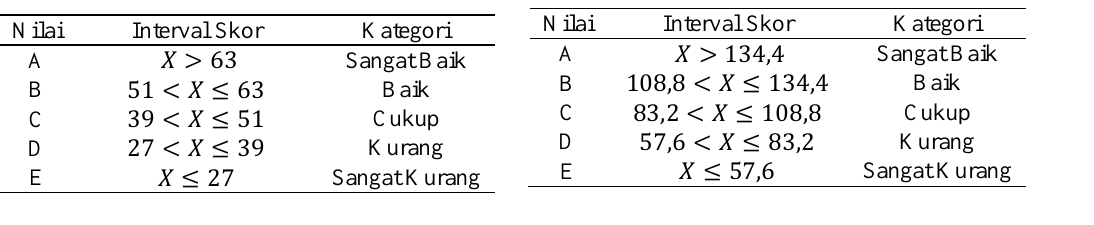
Tabel 5 . Angket Penilaian